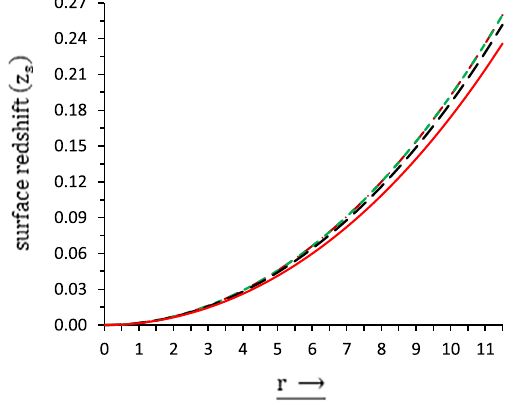
Fig. 8 Thetrendofthesurfaceredshiftfunction z s versus r .Thediffer- ent curves describe the following compact objects namely the red curve (solid) for 4U 1538-52, black curve (long-dashed) for SAX J1808.4- 3658, green color (small-dashed) for SMC X-1, vermilion color (dot- dashed) for LMC X-4. For plotting of this figure, we have used same data set of values as used in Fig.